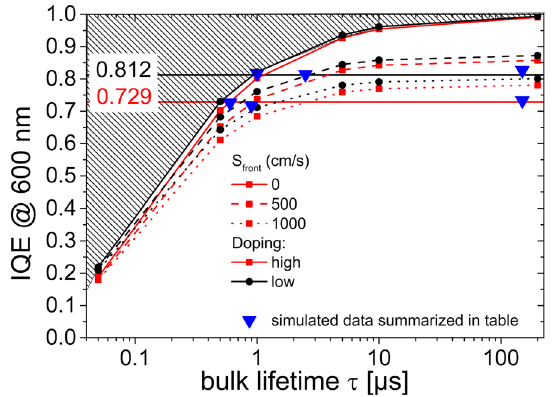
Figure 7. Simulated IQE at 600 nm of high (red squares) and low (black circles) doping IBC structures that were implemented into ASPIN3 as a function of bulk lifetime. IQE were simulated for different front surface recombination velocities (solid lines: 0 cm/s, dashed: 500 cm/s, dotted: 1000 cm/s). Measured IQE values at 600 nm of the two IBC cells from Fig. 3 are implemented as horizontal lines. Hatched area above the 0 cm/s lines is outside the parameter space for valid solutions for any set of lifetime and recombination velocity to reach an IQE value in this area. Face-down triangles represent simulated cells with IQE matching the ones measured for the three cases: bulk limited, intermediate and interface limited in Table